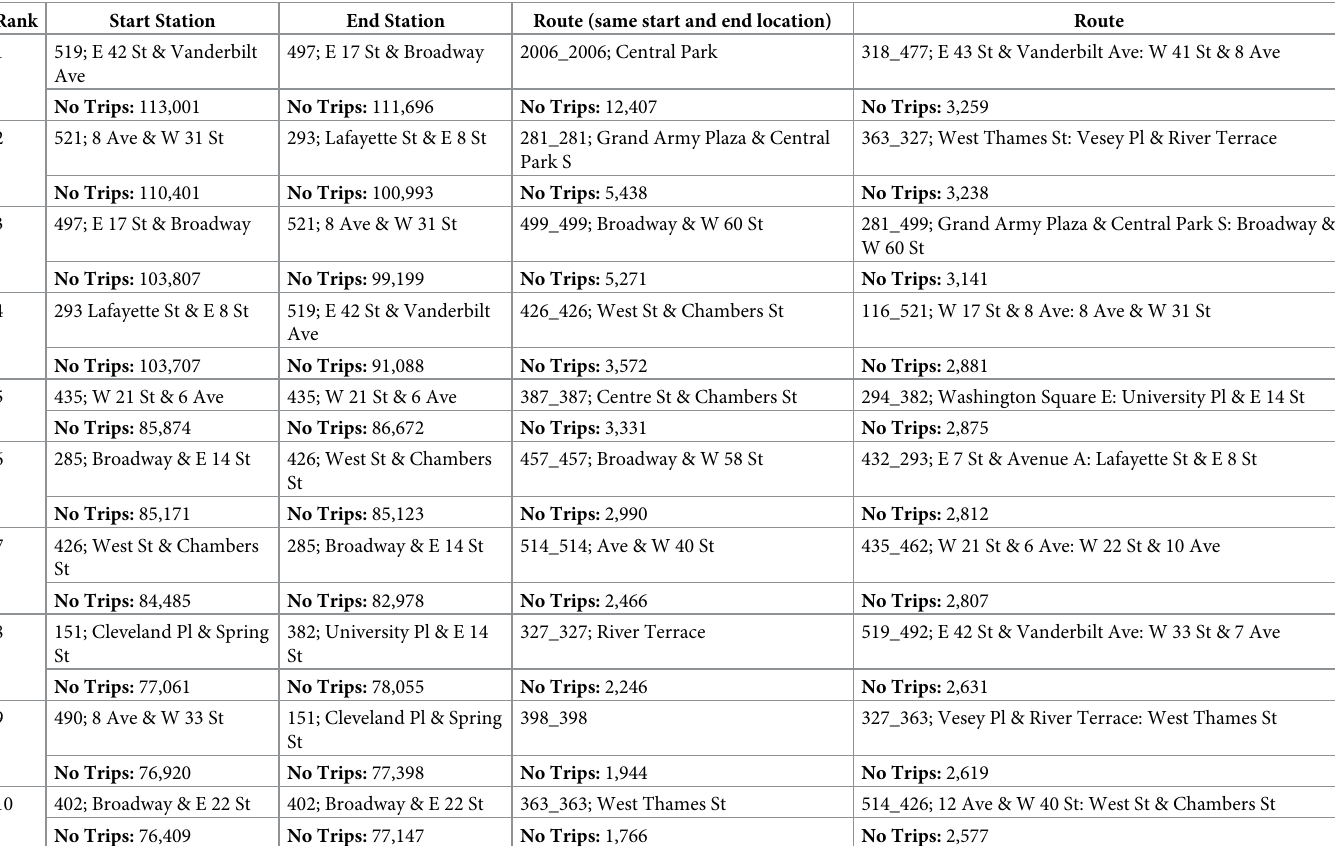
Table 3. Top ten ranked start station, end station and origin-destination routes based on the total number of trips recorded between July 2013 and June